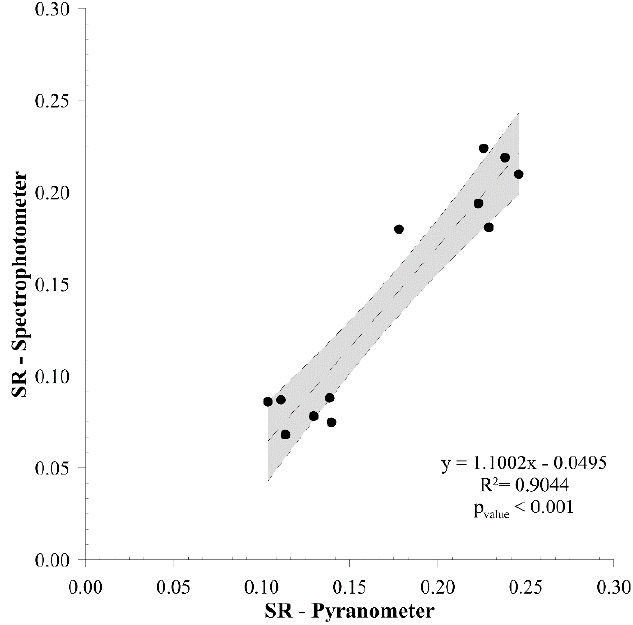
Figure 8. Correlation between spectrophotometer and pyranometer measured reflectance.